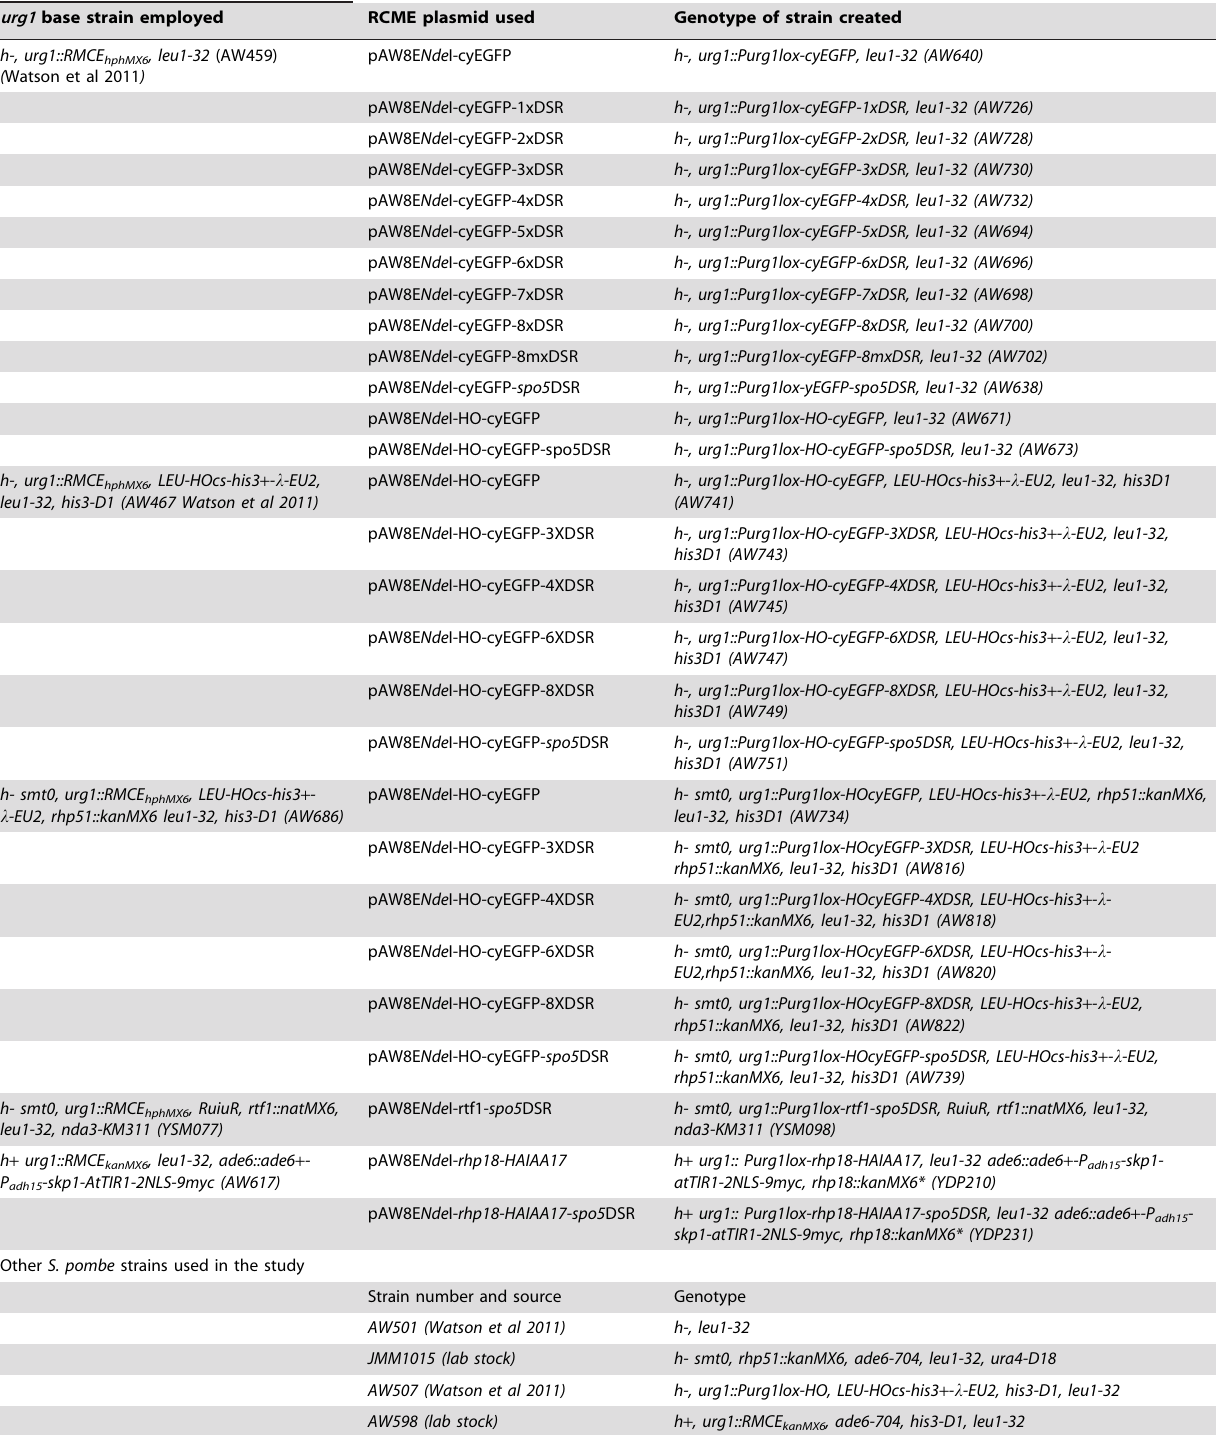
Strains created via Cre-lox recombination mediated cassette exchange during this